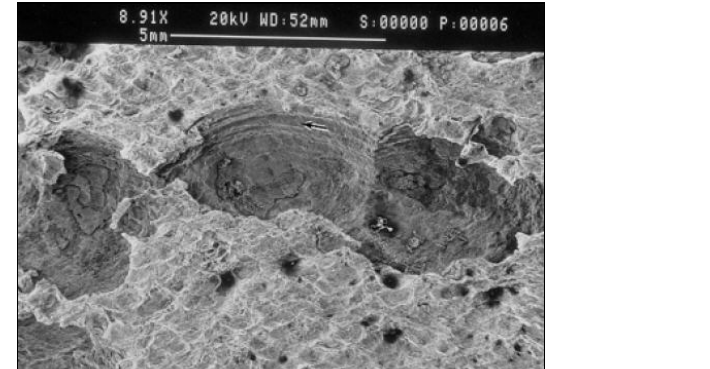
Figure 10 – Microscopic view of a corrosion pit in the Carlsbad pipeline Рис . 10 – Микрографическое изображение питтингов на трубопроводе в Карлсбаде Slika 10 – Mikrografski snimak korozivnog pita u cevovodu